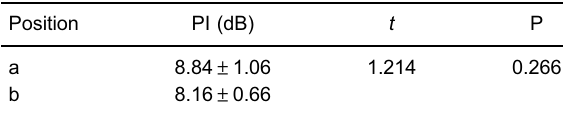
Table 2. Comparison of peak intensity (PI) at different regions of interest positions at a depth of 3 cm from the liver capsule. Position